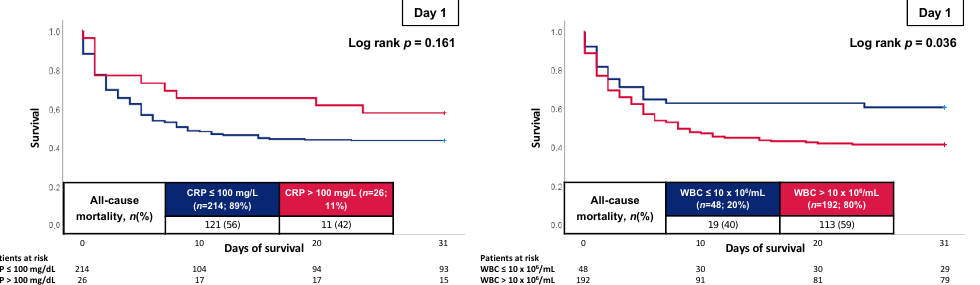
CRP, C-reactive protein; WBC, white blood cell count. Data is presented by AUC (95% CI). Level of significance p < 0.05. Bold type indicates statistical significance. * p value for the comparison of CRP and WBC according to Hanley et al. [23].